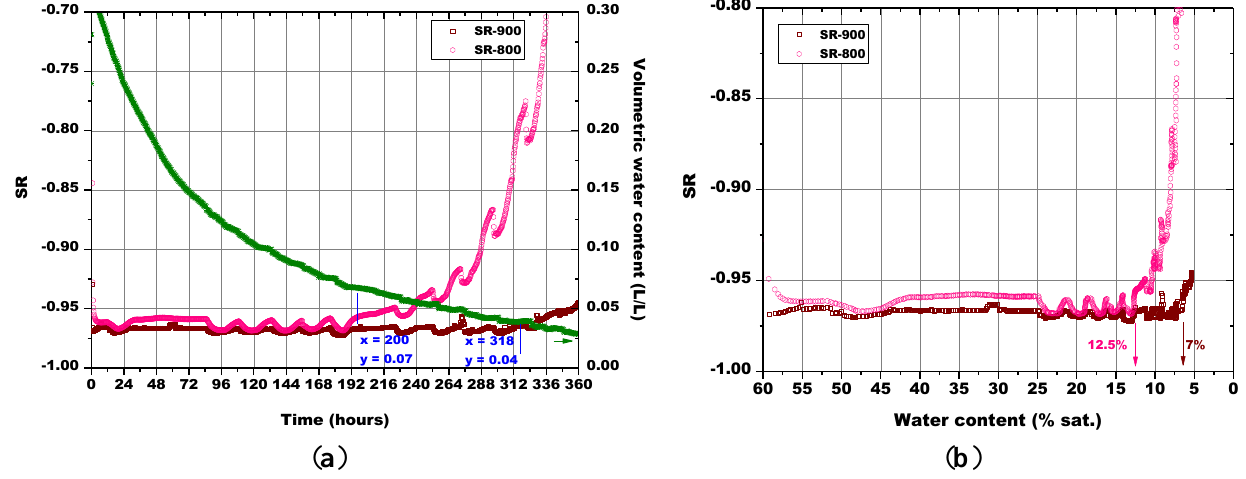
Figure 14. ( a ) Evolution of: the sensors response and of soil water content in function of time; ( b ) The sensors response in function of soil water content; comparison between the pellets fired at 800 °C and 900 °C (soil temperature = 41.5 °C ± 0.8 °C, soil density about 1.28 g/cm 3